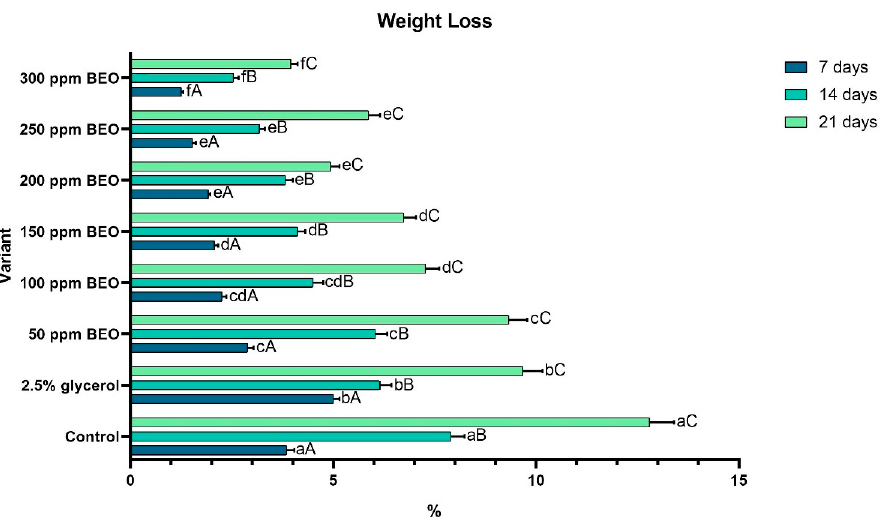
Figure 2. Effects of applied treatments on weight loss (%) during storage for 21 days at 8 ± 1 °C. Bars for the same sampling time followed by different lowercase letters are significantly different based on the least significant difference (LSD) test ( p < 0.05); Bars for the same treatment during storage time followed by different uppercase letters are significantly different based on the least significant difference (LSD) test ( p < 0.05).